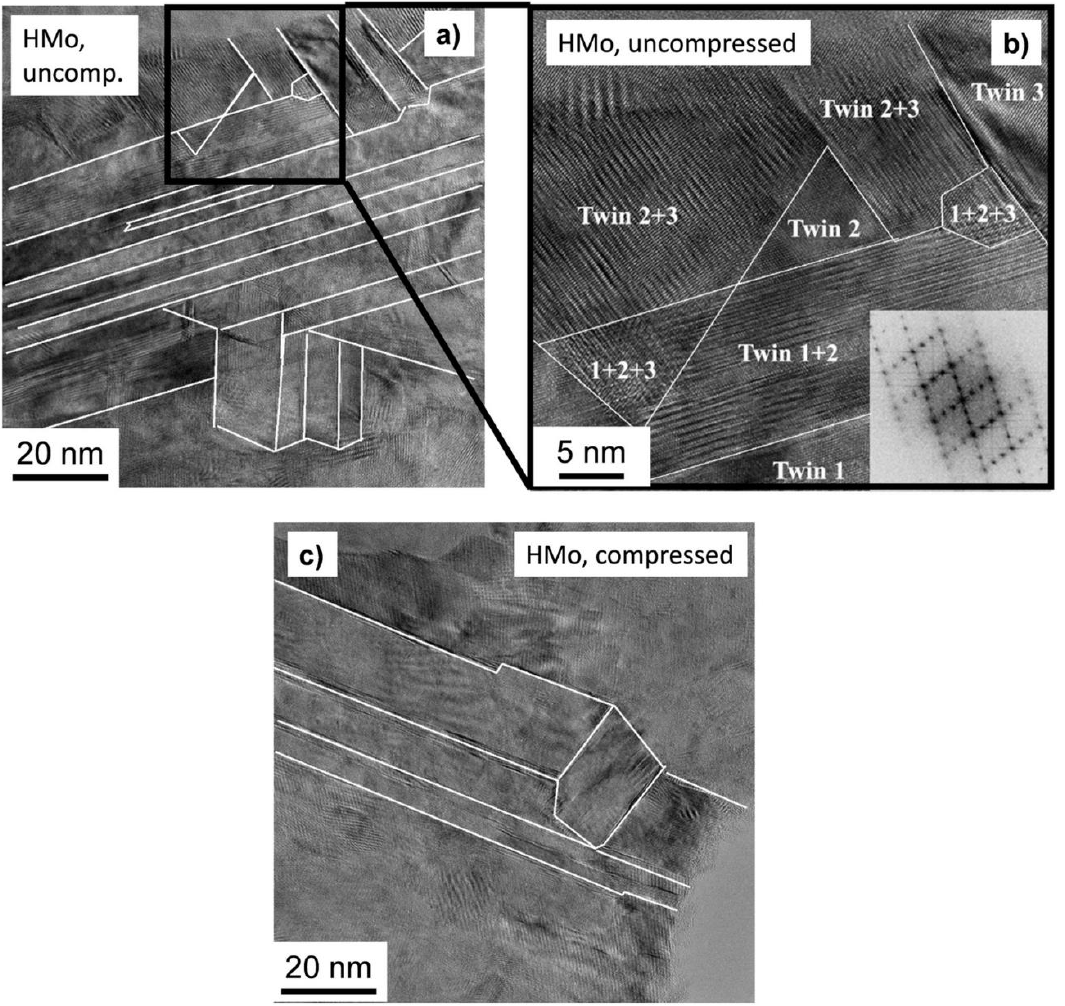
Figure 7. HRTEM images taken on uncompressed ( a , b ) and compressed ( c ) micropillars for the film HMo. The white lines indicate twin faults. ( b ) is a magnified part of ( a ) marked by the black frame. The diffraction pattern in ( b ) is obtained as the Fourier transform of the corresponding HRTEM image.